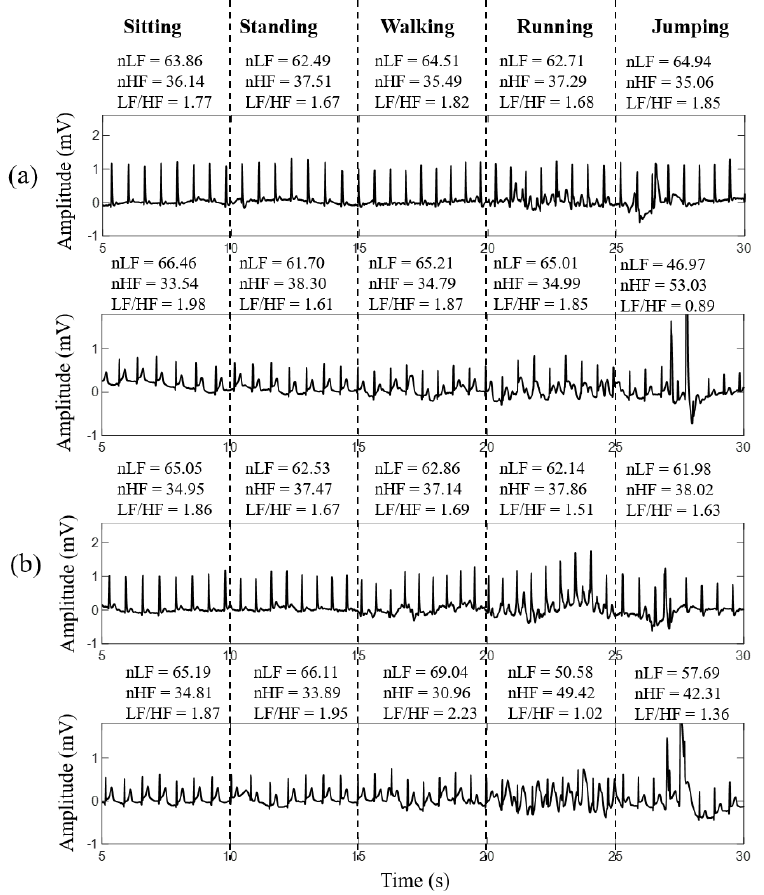
Figure 11. ECG signals of different participants acquired by ( a ) smart clothes and ( b ) conventional Ag/AgCl electrodes under different activities: sitting, standing, walking, running, and jumping.